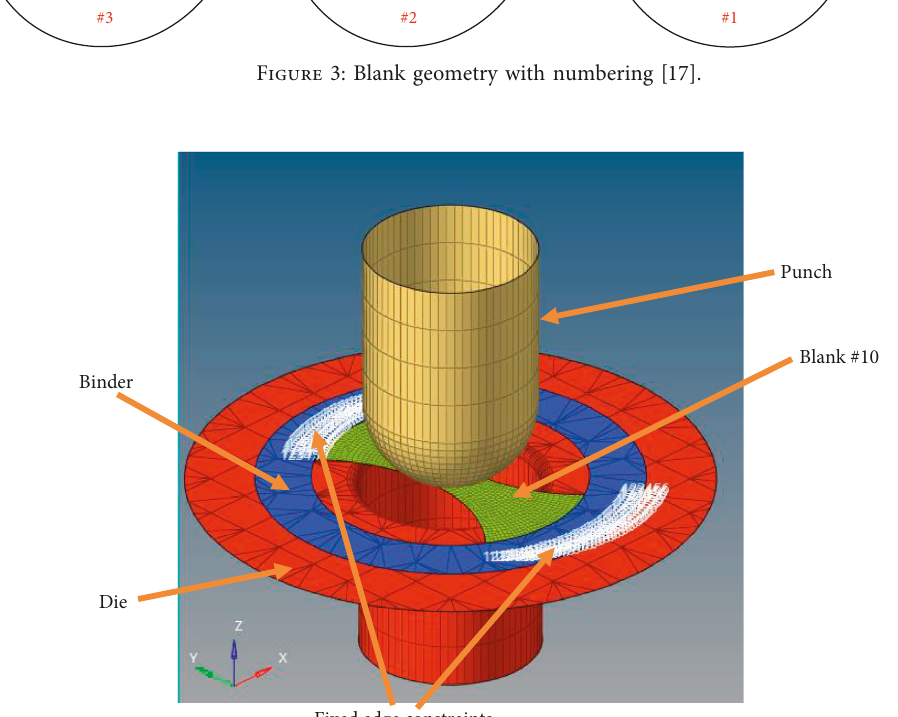
Figure 4: Typical LDH simulation